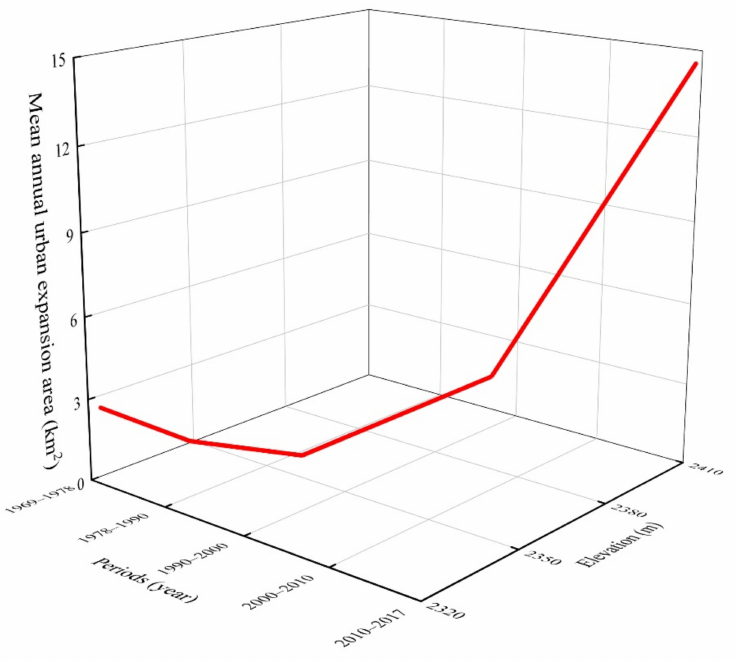
Figure 10. The accelerated urban expansion to higher altitude areas in Xining City from 1969 to